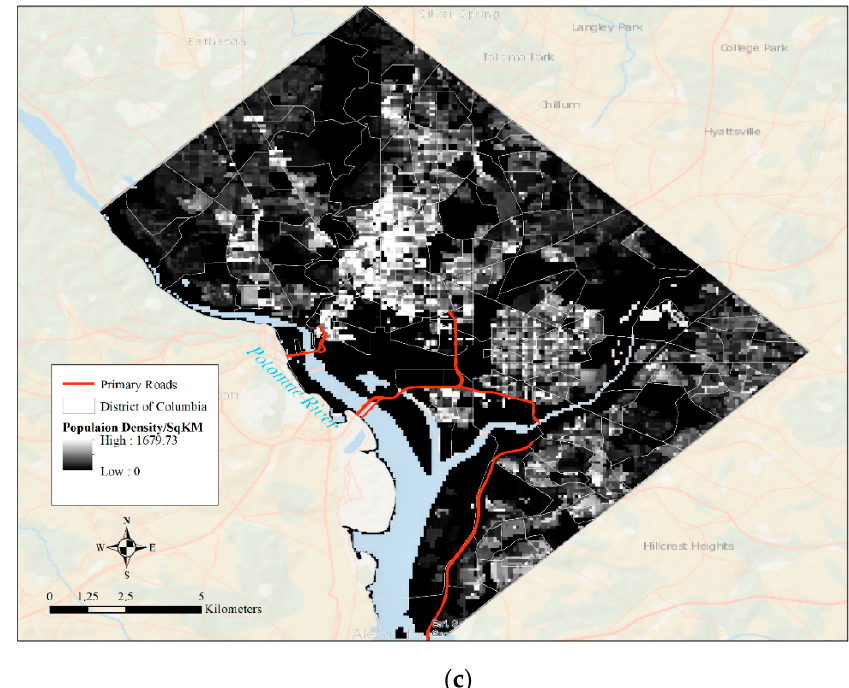
Figure 1. Population density distribution in 2020 for California and LA County ( a ), Chicago, IL ( b ), and Washington, District of Columbia ( c ).